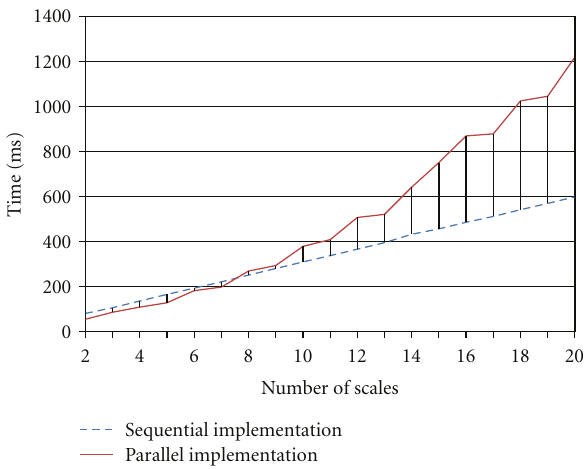
Figure 15: Relationship between the computational time (per one input image) and the number of scales ( N ) using the sequential and parallel implementation of the proposed detection